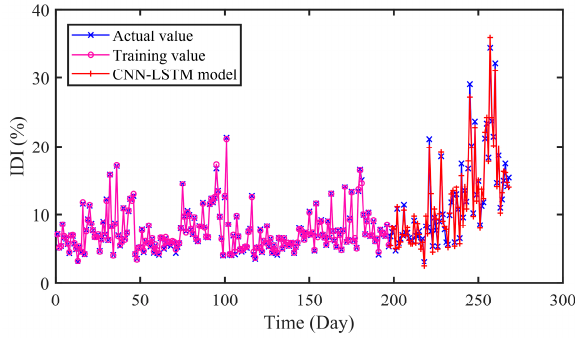
Figure 9. The predicted results of CNN-LSTM model .